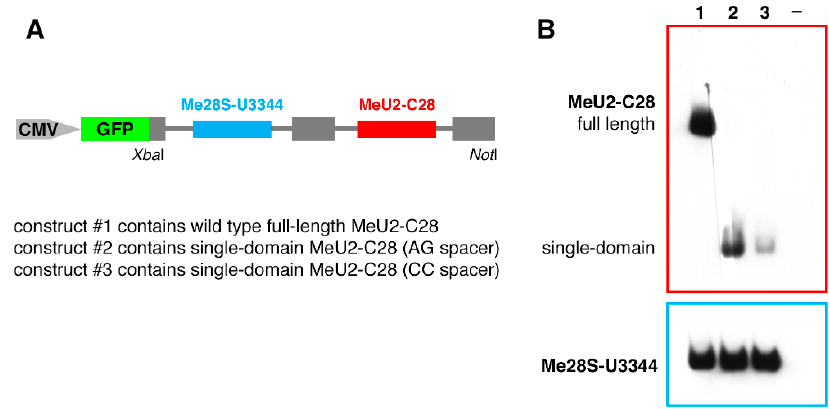
Figure 2. Expression of Drosophila snoRNA:Me28S-U3344 and scaRNA:MeU2-C28 (wild-type and single-domain mutant variants) in transfected HeLa cells. ( A ) Diagram of the snoRNA expression construct used for transfection. ( B ) Northern blot analysis of MeU2-C28 expression; Me28S-U3344 served as an internal control. Note fully processed guide RNA molecules in all samples. The expression level of the functional single-domain MeU2-C28 guide RNA is similar to that of full-length wild-type. A non-functional, single-domain mutant (extreme mutant with additional mutations 9 and 10) accumulated to a much lower level, yet was still normally processed.